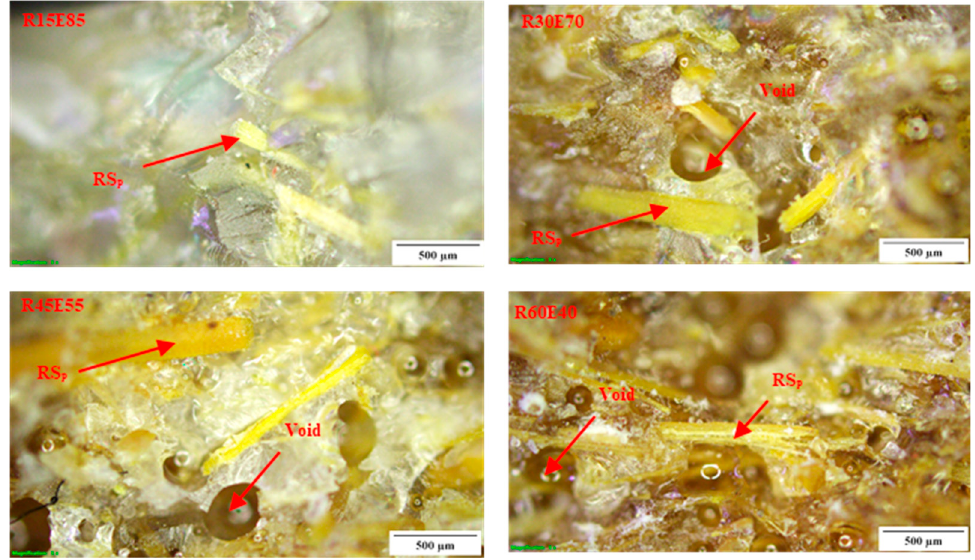
Figure 13. Tensile load-fractured surfaces of test samples.